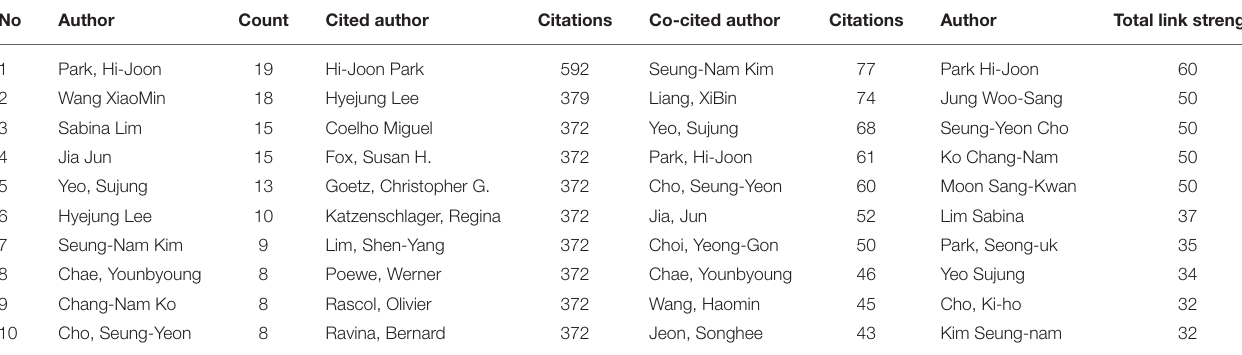
TABLE 3 | Top 10 authors for publications on acupuncture for PD.